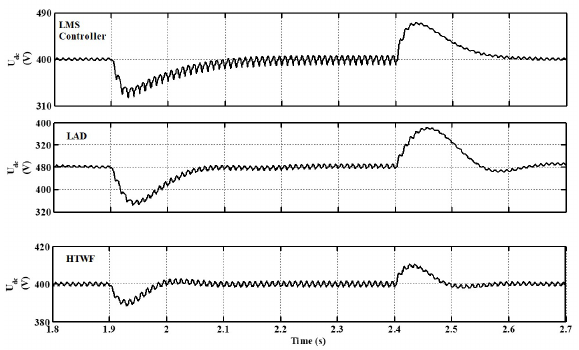
Fig. 9. Comparison performance of LMA, LAD and HTWF based control